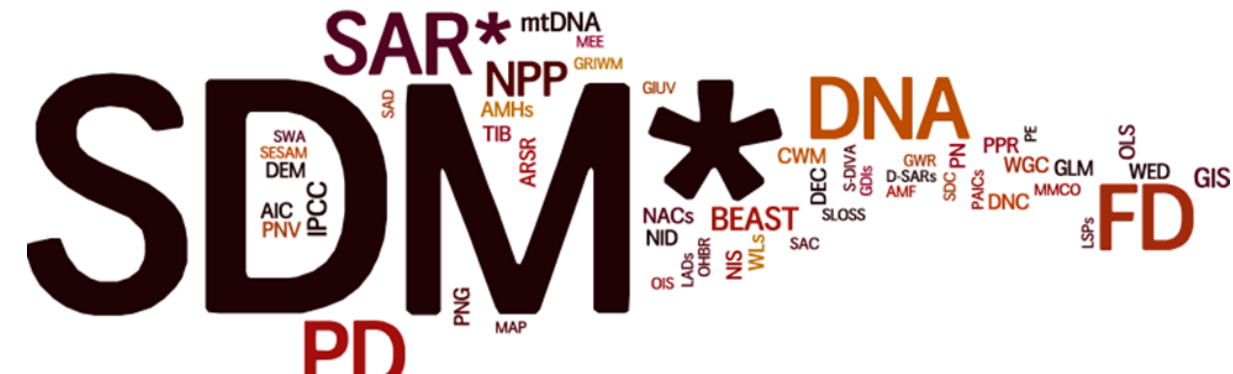
Figure 5. Abbreviations appearing commonly in abstracts submitted for the 7 th IBS biennial meeting. Analysis as de- scribed in the caption to Figure 1; based on n = 325. Acronyms that occurred in fewer than three abstracts were w excluded from the analyses. Asterisks indicate the word also occurred in plural form. The most common term (“SDM*”) in the analysis occurred in 60 abstracts; the least common term in the analysis occurred in three abstracts. Comparison with Figures 1–3 emphasizes key topics considered during the 7 th IBS biennial